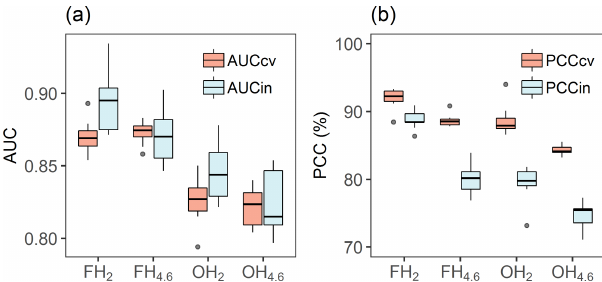
Figure 5. Model performances based on (a) area under the curve values with 10-fold cross-validation (AUC cv ) and against indepen- dent test data (30% of sites) (AUC in ) as well as (b) percent of cor- rectly classified with 10-fold cross-validation (PCC cv ) and against independent data (PCC in ).